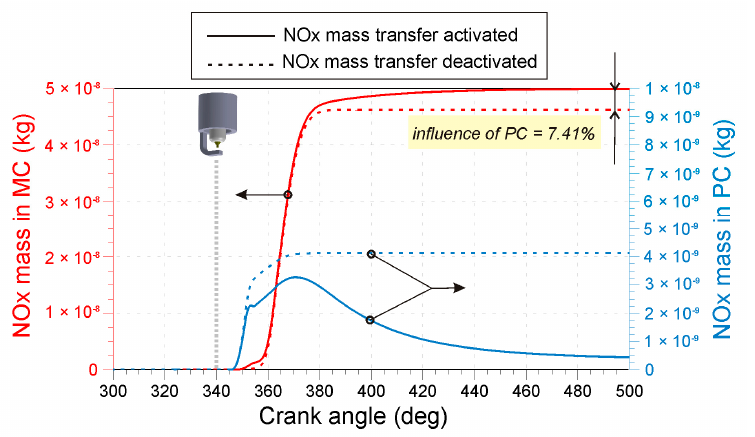
Figure 5. Contribution of pre-chamber NOx on the total NOx emissions in main chamber—example for operating point at exhaust air excess ratio of 1.8.